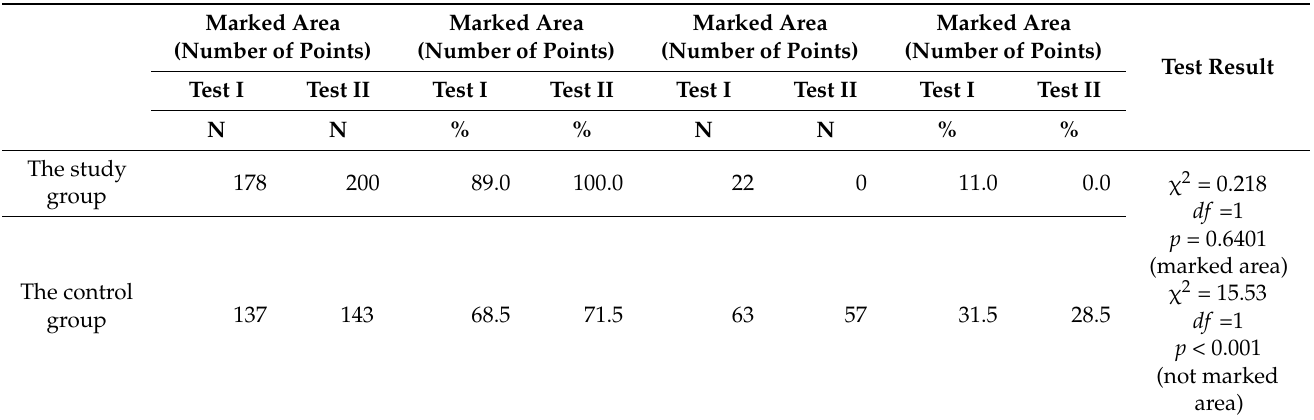
Table 9. Proprietary interactive tactile test “breast self-examination”, and the total number of marked points—Test I and